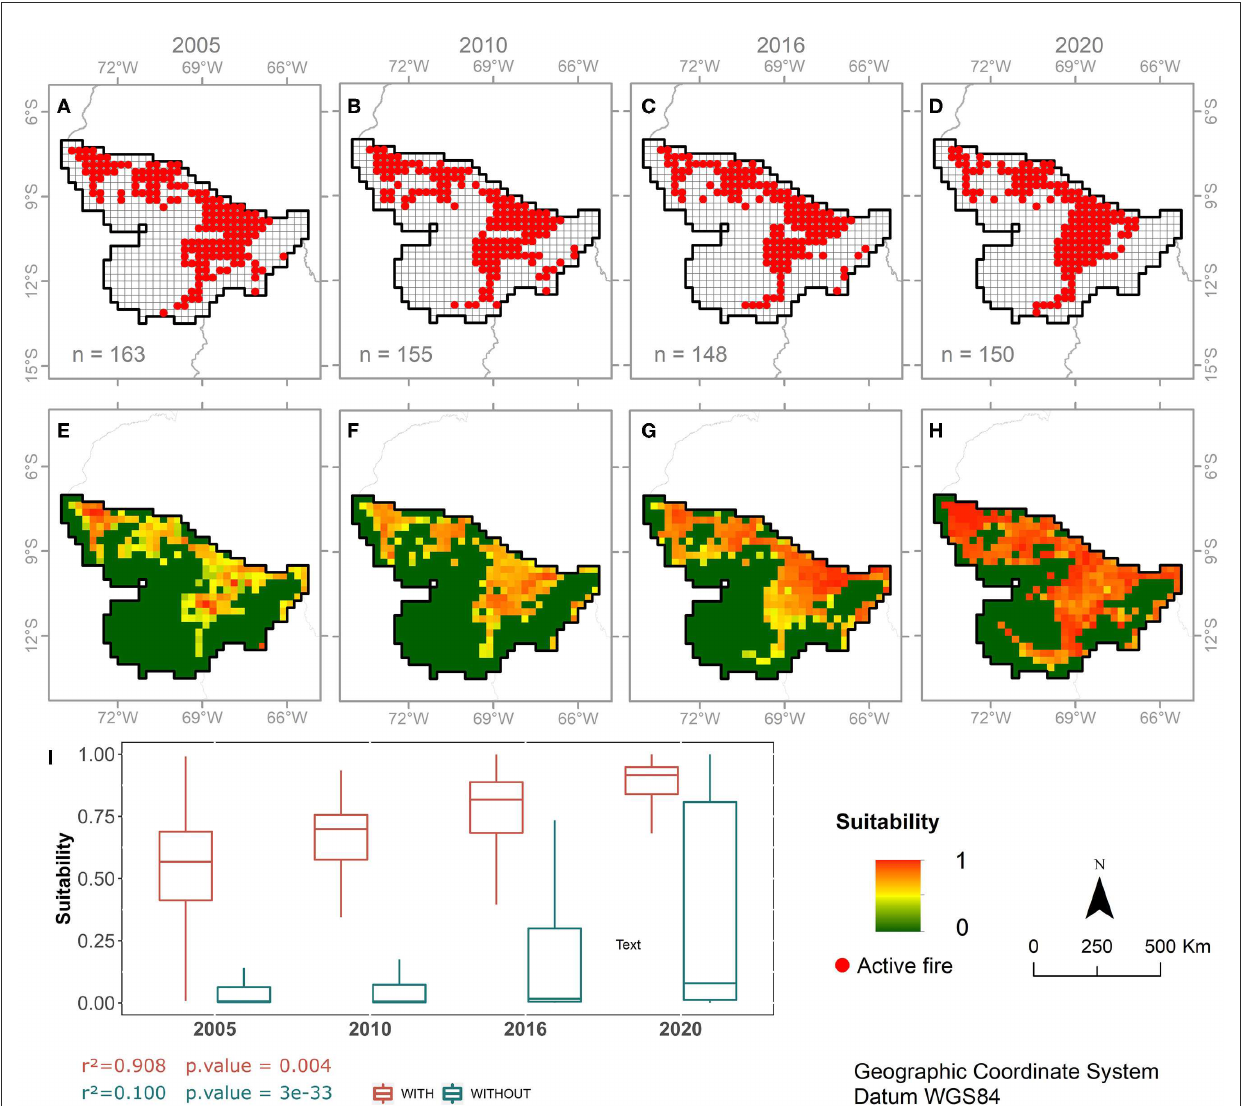
FIGURE3 Distribution of grid cells for the month of September with 25 or more hot pixels (A–D) , “ n ” represents the grid-cell count) for 2005, 2010, 2016, and 2020, and their corresponding model of risk of fire occurrence (E–H) . The boxplot (I) shows the distribution of probability for fire occurrence in grid cells with and without the presence of 25 or more hot pixels, where the horizontal lines that split the box in two are the median value of each distribution, the lower and upper horizontal lines of the box are the 25th percentile and 75th percentile, and the vertical lines are the minimum and maximum range of the distribution. The probability values ranged from 0 to 1, with 1 representing the most fire-prone area and 0 the least fire-prone